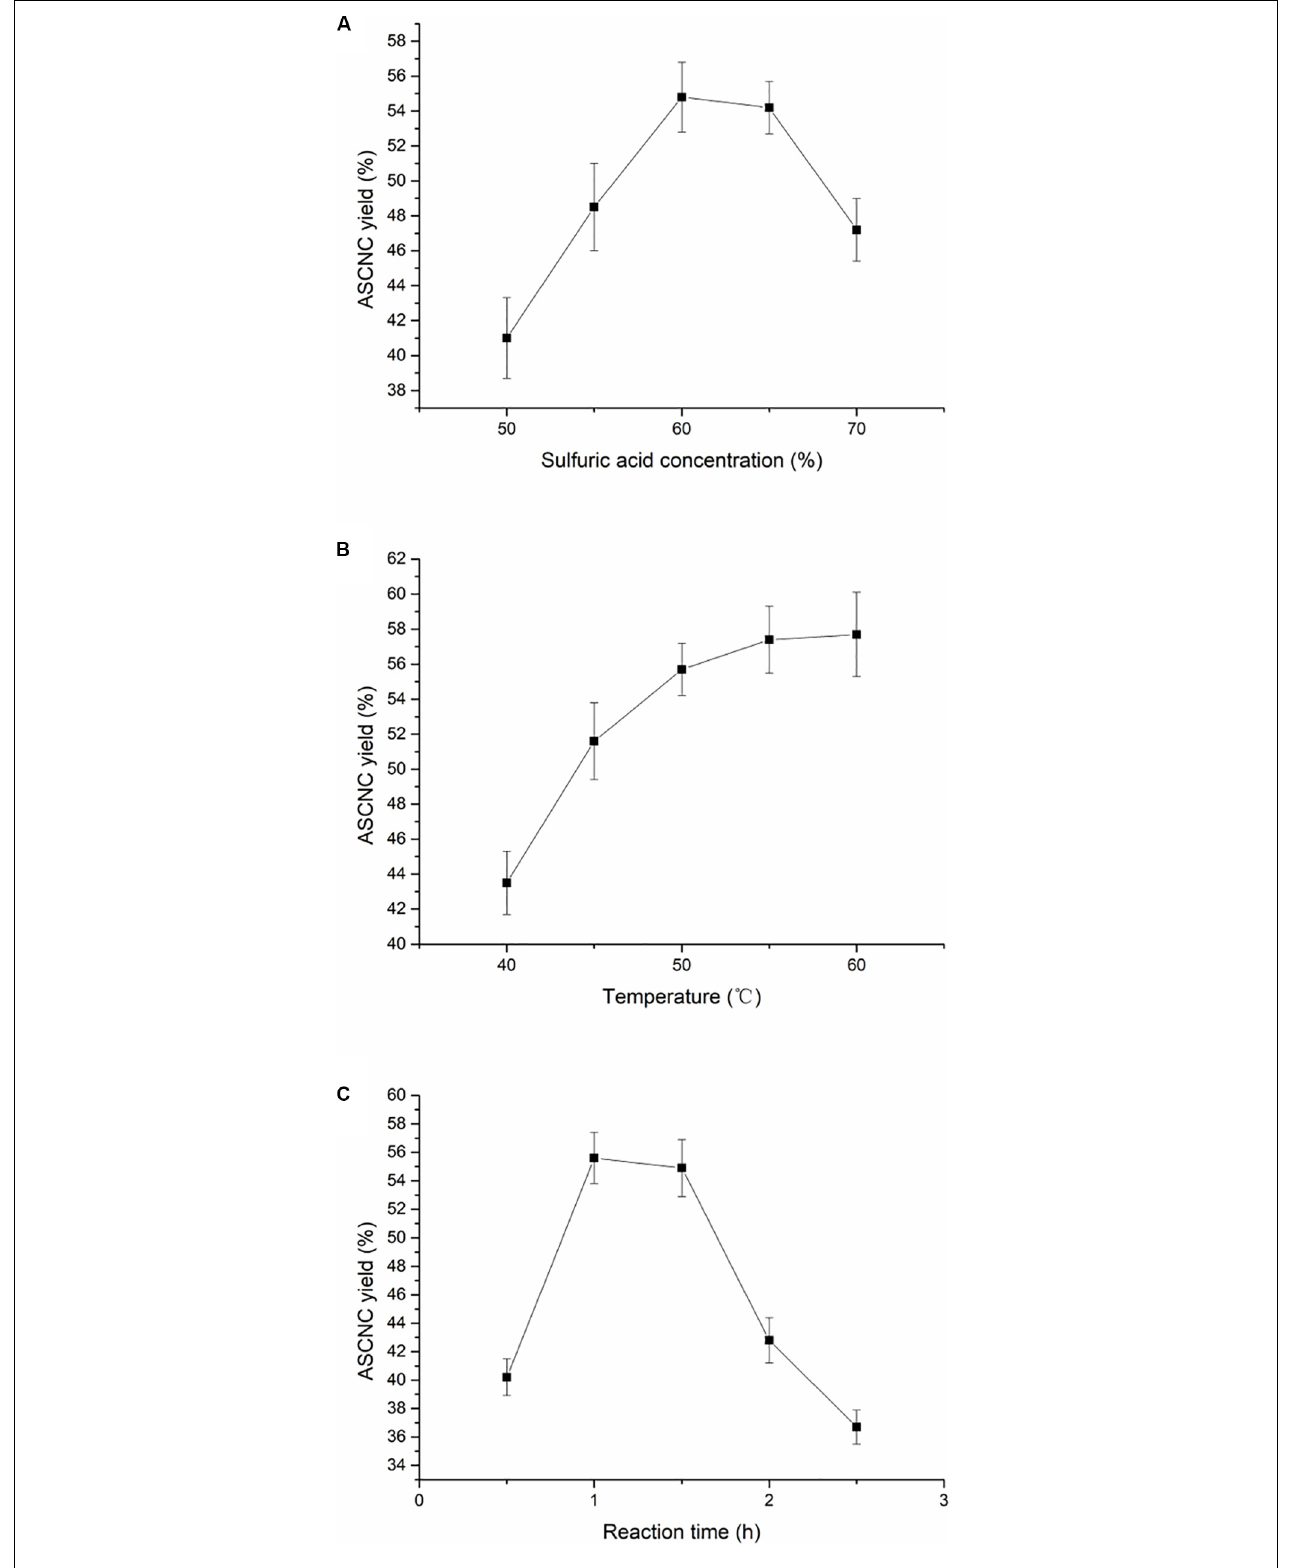
FIGURE 1 | Effect of reaction conditions on the yield of ASCNC. (A) Sulfuric acid concentration; (B) reaction temperature; (C) reaction time.